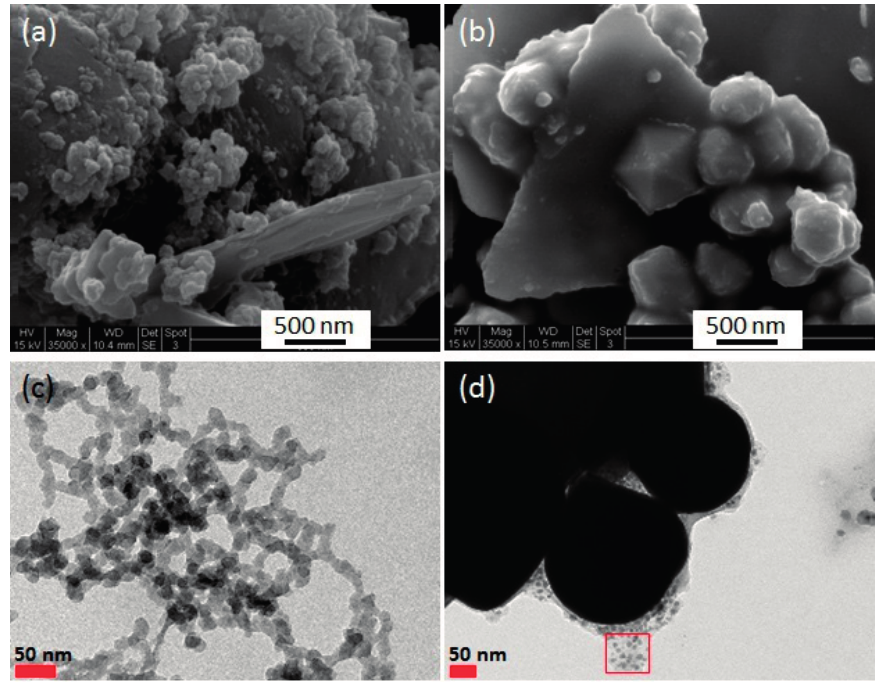
Figure 5. SEM ( a , b ), TEM ( c , d ) images of synthesized Au; samples with the green chemistry method: ( a , c ) for Au sample microwaved for 3 min, and ( b , d ) for Au sample microwaved for 6